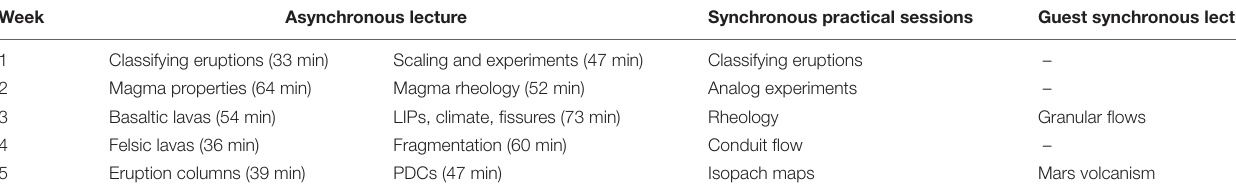
TABLE 1 | Volcanology syllabus listed for each teaching week.